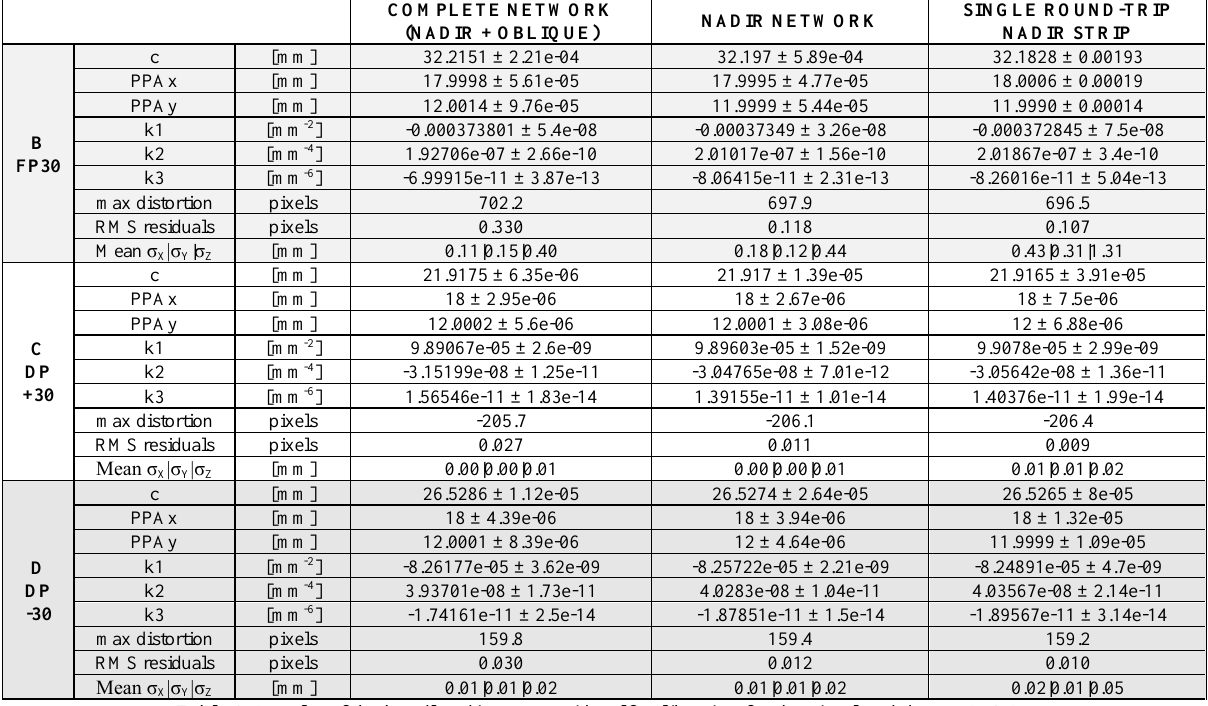
Table 2. Results of the bundle adjustment with self-calibration for the simulated dataset